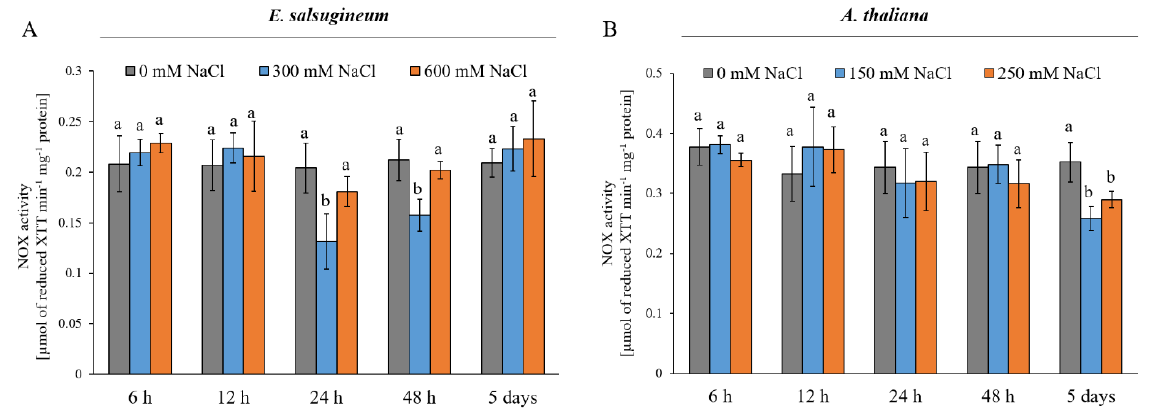
Figure 2. Total activity of NOX in leaves of E. salsugineum ( A ) and A. thaliana ( B ) plants under NaCl stress conditions. E. salsugineum plants were exposed to 0, 300, or 600 mM NaCl and A. thaliana were exposed to 0, 150, or 250 mM NaCl for 6, 12, 24, or 48 hours or 5 days. Data represent mean ± SD ( n = 3). Different letters illustrate significant differences at p ≤ 0.05.